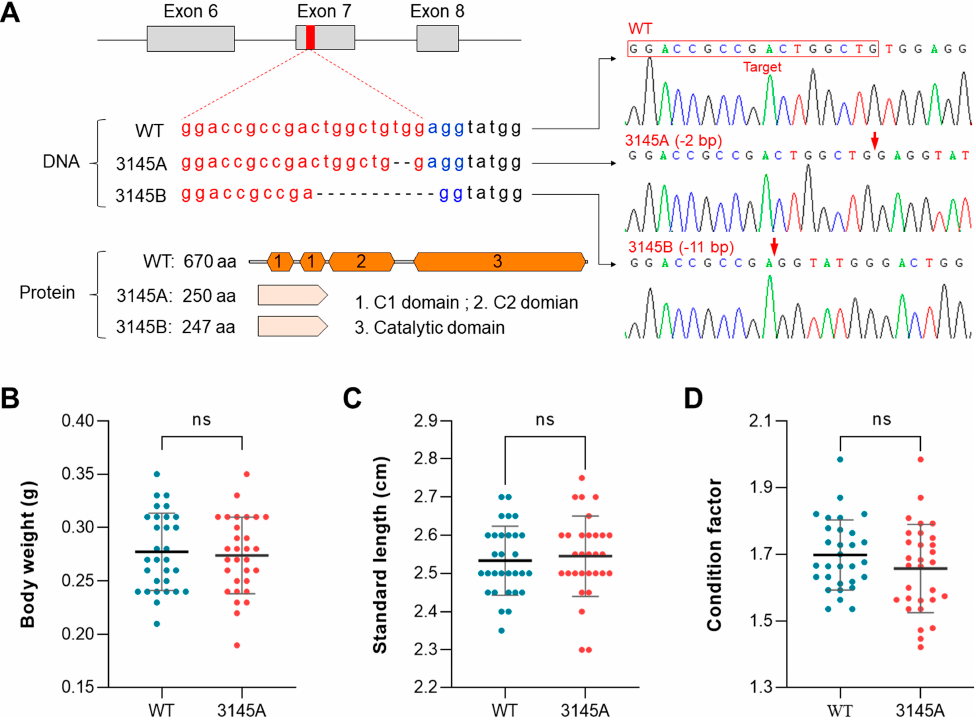
Figure 2. Genotypes and body measurements of the prkcaa -null zebrafish. ( A ) Genotypes of the prkcaa − / − mutants. The target sequence was located in the seventh exon of the zebrafish prkcaa gene. Two mutant lines were generated and designated as ZKO3145A (3145A, − 2 bp) and ZKO3145B (3145B, − 11 bp). The target sequence, deleted nucleotides and the truncated proteins are illustrated. The red arrows indicate the joining sites of the broken DNA strands. ( B – D ) Measurements include body weight ( B ), standard length ( C ) and condition factor ( D ) for the adults of the WT and 3145A mutants. The error bars represent standard error ( n = 30); ns, no significant difference. The different colored lines represent the four bases, A, T, C and G (shown above the lines). The different colored dots indicate the fish lines WT and 3145A (shown below the x-axis).